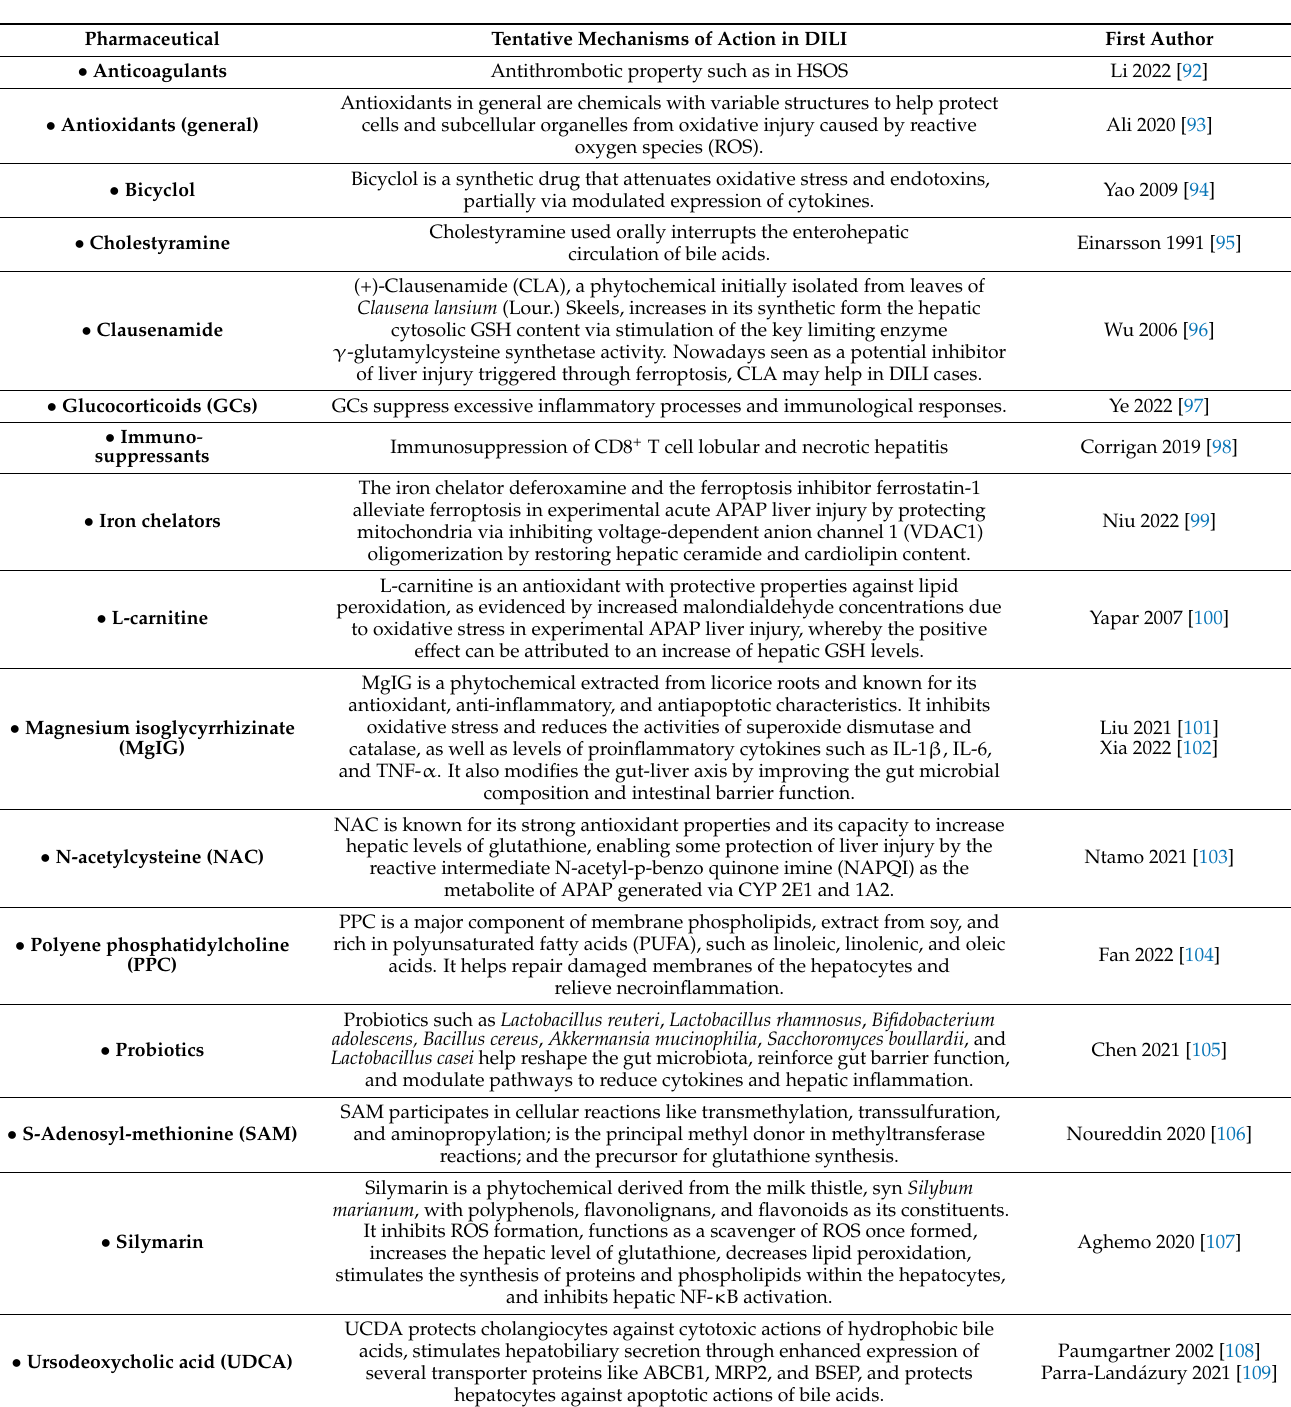
Table 3. Potential pharmaceuticals for treatment or prophylaxis of